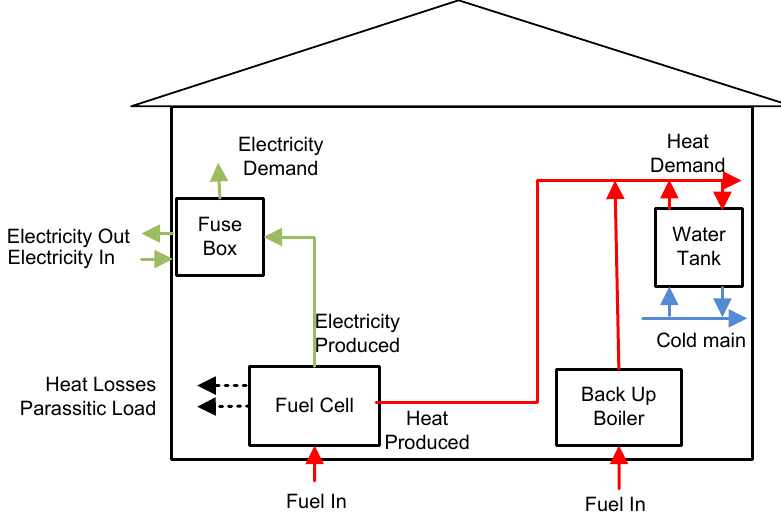
Figure 1. Fuel cell system for residential